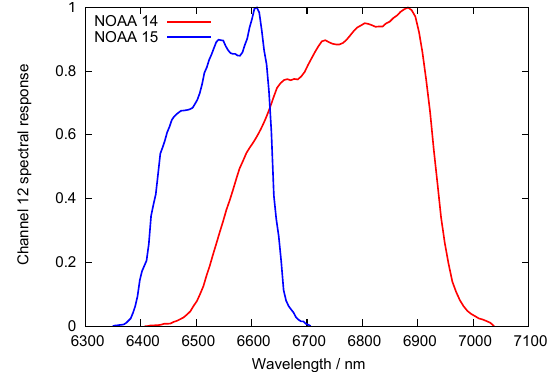
Figure 1. Channel 12 spectral response functions of the HIRS 2 instrument on NOAA 14 and the HIRS 3 instrument on NOAA 15.